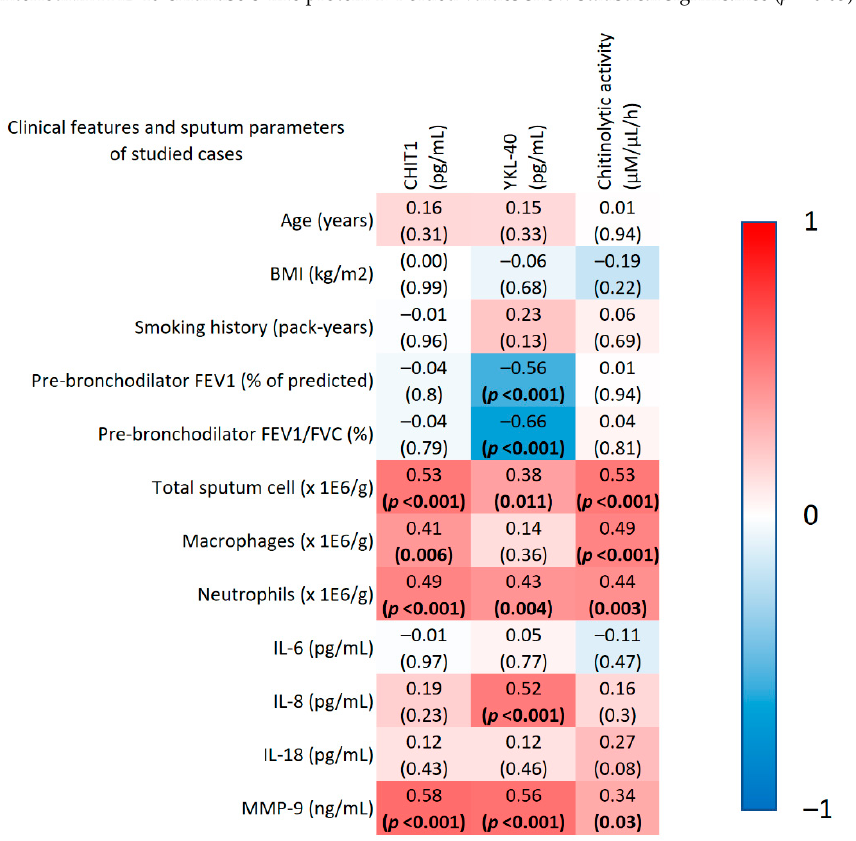
Results are expressed as correlation coefficient (r) and p -value. Abbreviations: CHITI1-chitotrio- sidase; IL-interleukinYKL-40-chitinase-3-like protein 1. Bolded values show statistical significance ( p < 0.05).